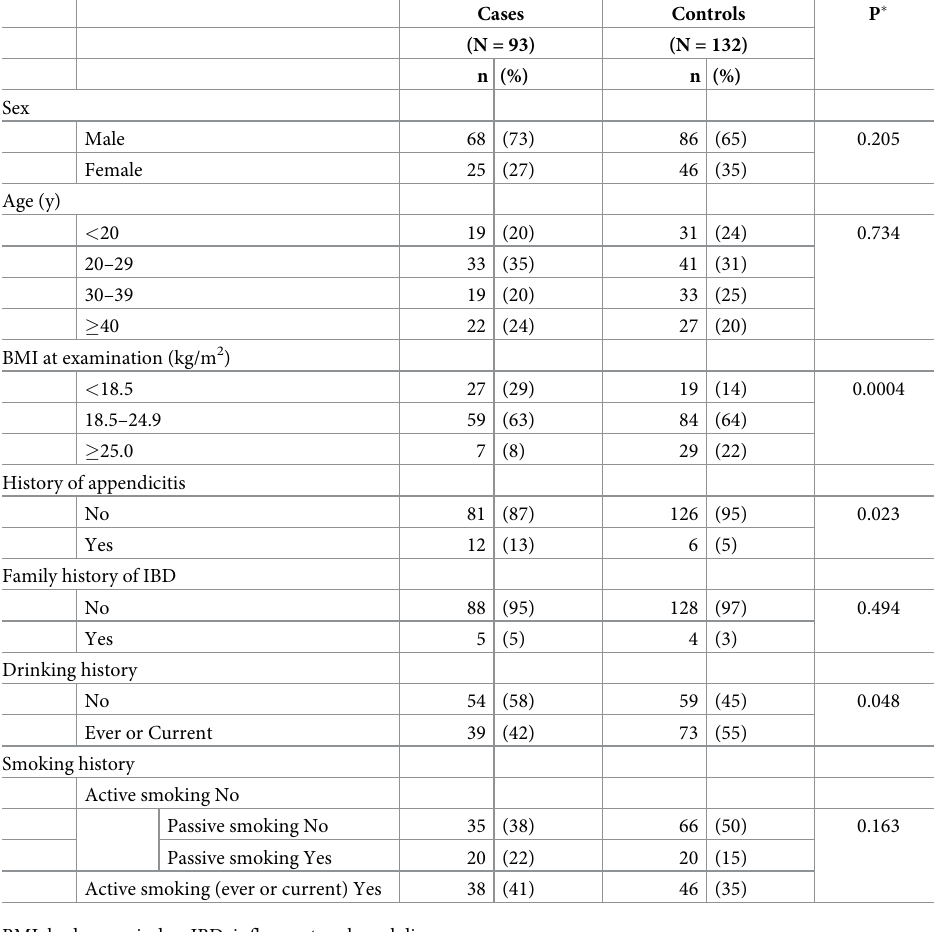
Table 2. Characteristics of the cases and